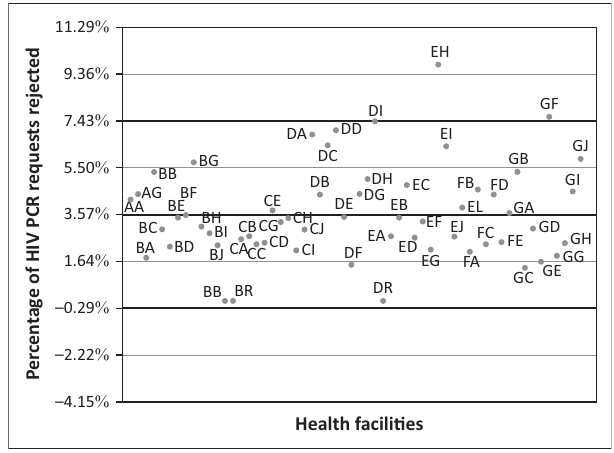
FIGURE 2: Percentage of HIV-1 PCR requests rejected because of pre-analytical factors by health facilities in KwaZulu-Natal province, South Africa, in 2014. Each health facility is represented by a two-letter code. The analysis included data from 88 481 dried blood spot specimens. The horizontal line at 3.57 % indicates the mean percentage of rejected requests for all facilities. The horizontal lines at 7.43 % and -0.29 % indicate two standard deviations from the mean.